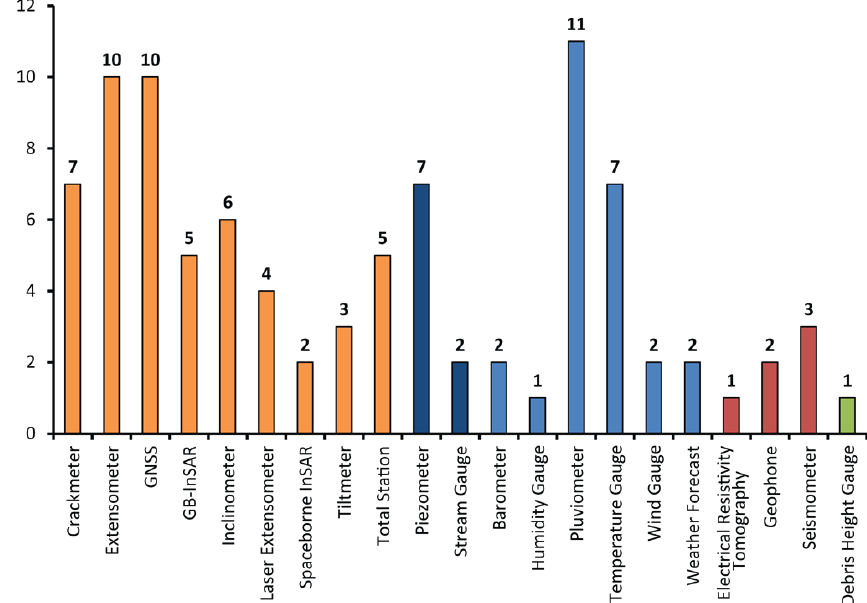
Fig. 7. Inventory of the different techniques used for the 21 reported monitoring networks in order to measure surface and sub-surface displacements (in orange), water and groundwater table levels (in dark blue), weather conditions (in light blue), geophysical properties (in red) and available sediment volumes (in light green). Theoretical and technical details of those techniques are developed in Stumpf et al. (2011) and Michoud et al. (2012).